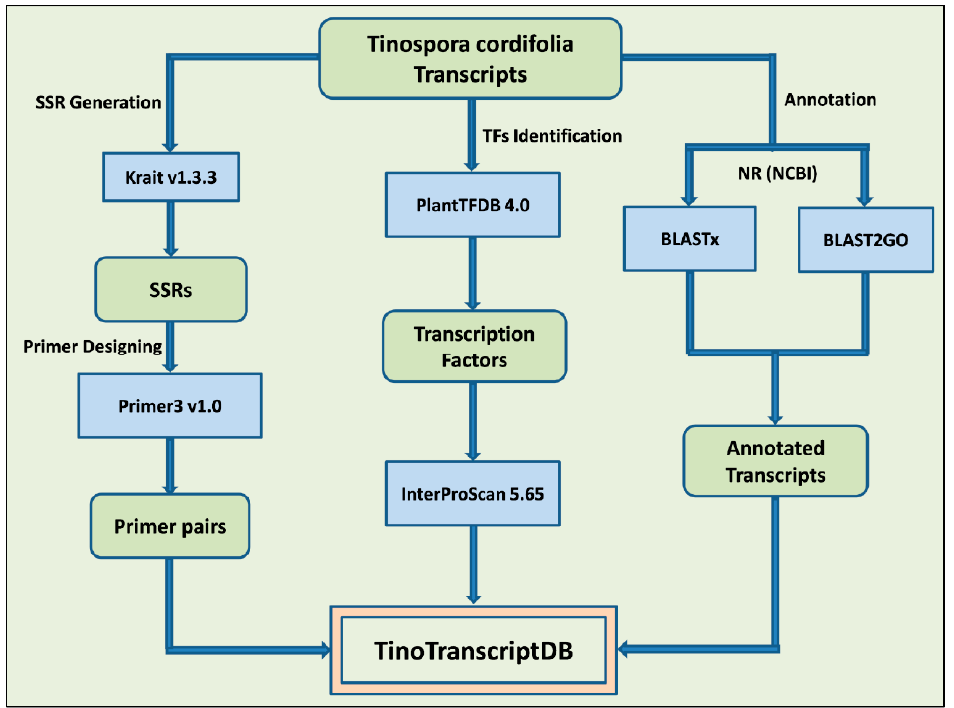
Figure 2. Process flow diagram and tools used for the transcriptome SSR marker identification, primer designing, annotation and transcription factor categorization.